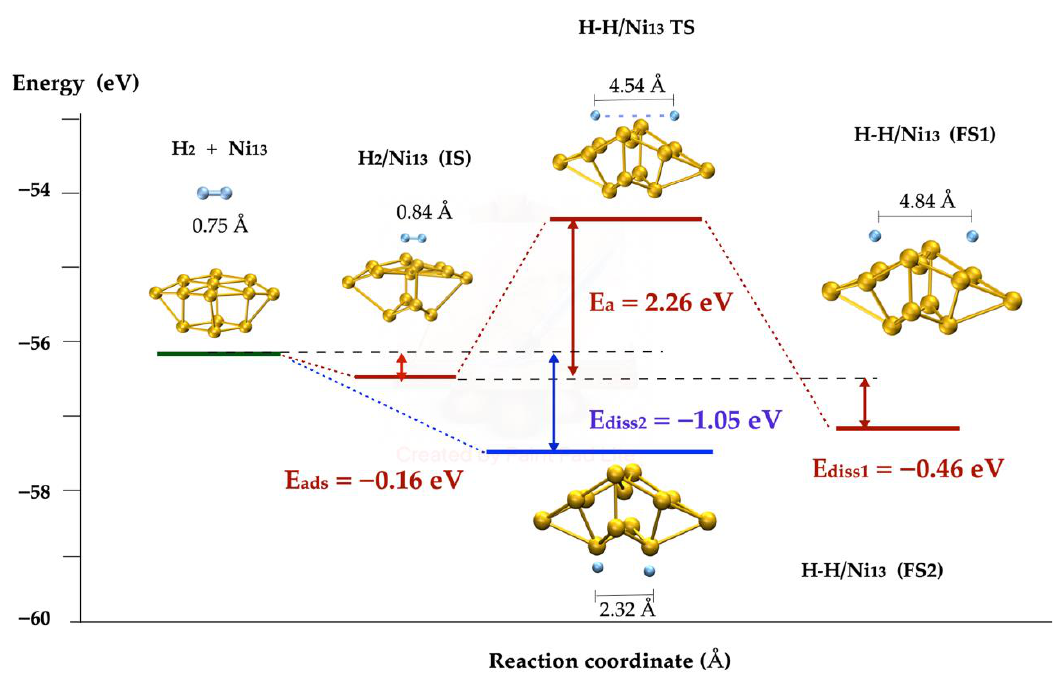
Figure 3. H 2 dissociation pathways on Ni 13 cluster. The blue lines mark the spontaneous pathway and red lines correspond to the activated one. The blue spheres represent H atoms and yellow spheres are Ni atoms.